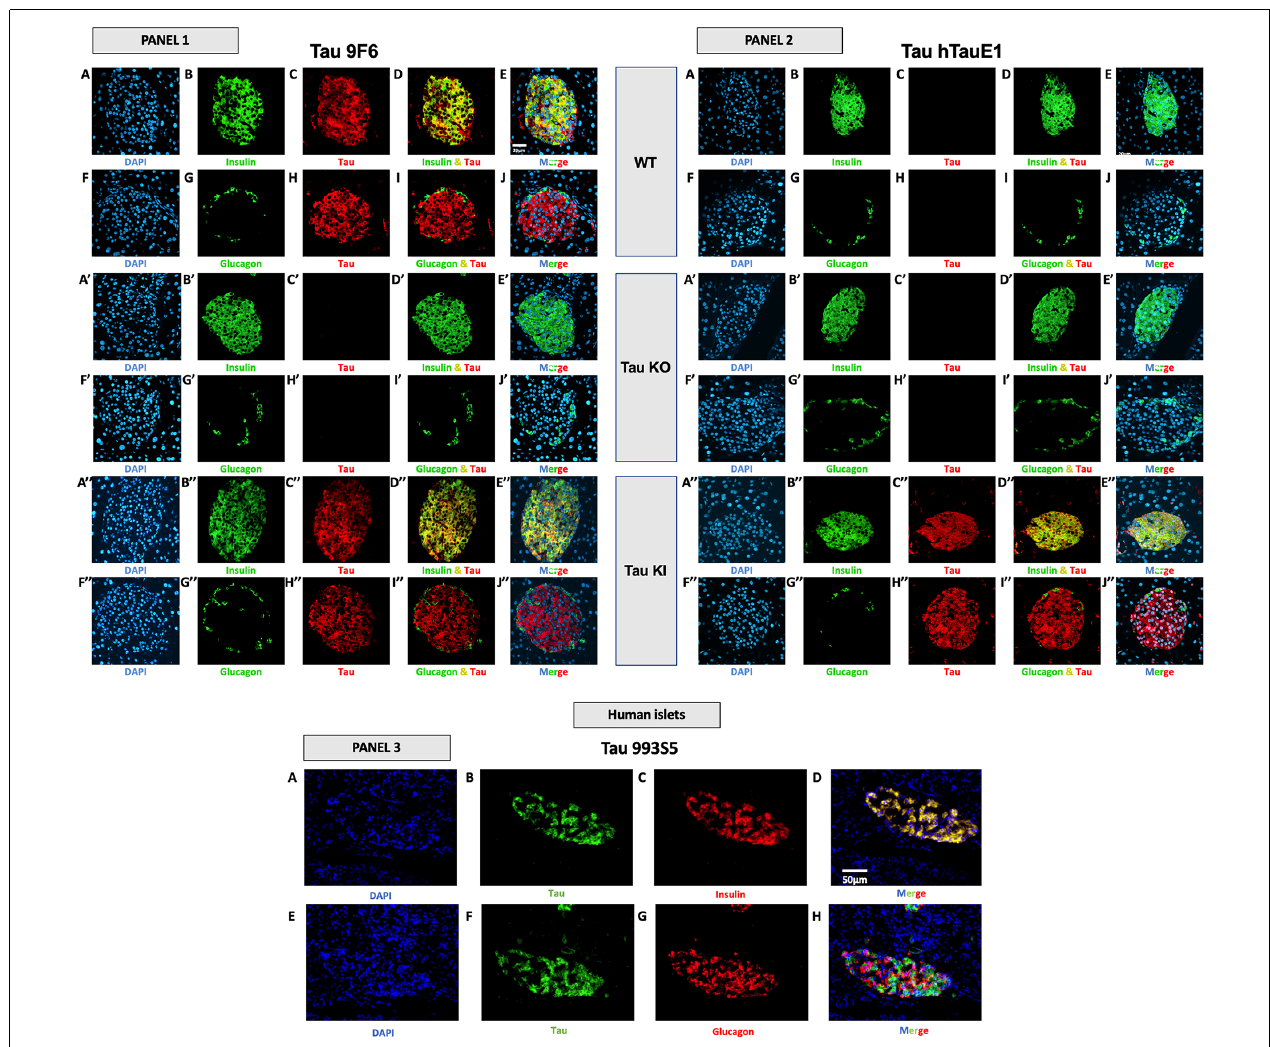
FIGURE 5 | Tau expression in mouse and human pancreatic islets and colocalization with insulin and glucagon. Panel 1 (9F6 antibody). Tau WT mice . (A–E) Double immunofluorescence staining for insulin (green) and tau (red) in pancreatic islets from adult WT mice. Blue: DAPI nuclear counterstaining. (F–J) Double immunofluorescence staining for glucagon (green) and tau (red) in pancreatic islets from adult WT mice. Blue: DAPI nuclear counterstaining. Tau KO mice (A’–E’) Double immunofluorescence staining for insulin (green) and tau (red) in pancreatic islets from adult tau KO mice. Blue: DAPI nuclear counterstaining. (F’–J’) Double immunofluorescence staining for glucagon (green) and tau (red) in pancreatic islets from adult tau KO mice. Blue: DAPI nuclear counterstaining. (K’–O’) . Tau KI mice (A”–E”) Double immunofluorescence staining for insulin (green) and tau (red) in pancreatic islets from adult KI mice. Blue: DAPI nuclear counterstaining. (F”–J”) Double immunofluorescence staining for glucagon (green) and tau (red) in pancreatic islets from adult tau KI mice. Blue: DAPI nuclear counterstaining. These observations were reproduced in at least three independent experiments and samples. Panel 2 tau expression using htauE1 antibody against human tau. Tau WT mice. (A–E) Double immunofluorescence staining for insulin (green) and tau (red) in pancreatic islets from adult WT mice. Blue: DAPI nuclear counterstaining. (F–J) Double immunofluorescence staining for glucagon (green) and tau (red) in pancreatic islets from adult WT mice. Blue: DAPI nuclear counterstaining. Tau KO mice (A’–E’) Double immunofluorescence staining for insulin (green) and tau (red) in pancreatic islets from adult tau KO mice. Blue: DAPI nuclear counterstaining. (F’–J’) Double immunofluorescence staining for glucagon (green) and tau (red) in pancreatic islets from adult tau KO mice. Blue: DAPI nuclear counterstaining. Tau KI mice (A”–E”) Double immunofluorescence staining for insulin (green) and tau (red) in pancreatic islets from adult KI mice. Blue: DAPI nuclear counterstaining. (F”–J”) Double immunofluorescence staining for glucagon (green) and tau (red) in pancreatic islets from adult tau KI mice. Blue: